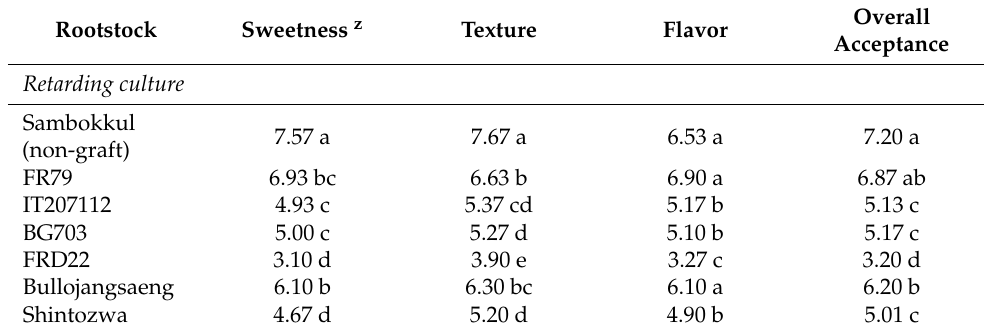
Table 5. Cont . Rootstock Sweetness z Texture Flavor